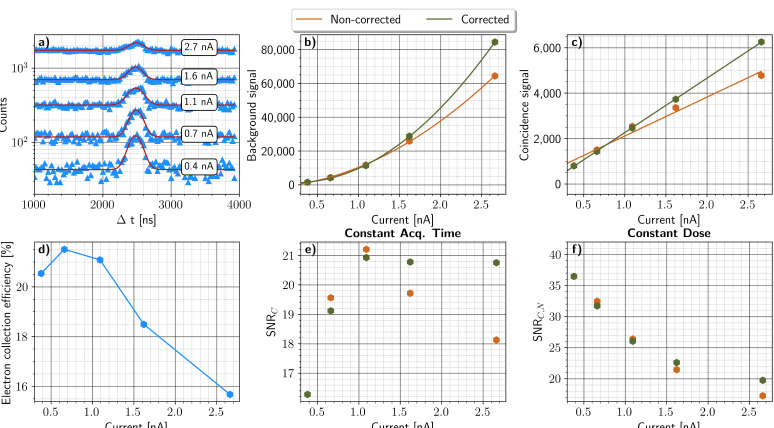
Figure 2. ( a ) Coincidence histograms as a function of time delay between EELS and EDX event streams for a varying beam current at constant acquisition time (y scale logarithmic). ( b ) The uncorrelated background signal as a function of incoming beam current (brown). The background scales quadratically with incoming current. In green, the corrected expected background signal which would be recorded for an ideal electron detector with constant efficiency as a function of current. ( c ) The number of coincidence events as a function of incoming current scales only linearly with incoming current. The corrected signal taking the efficiency into account is shown (green). Please note that the corrected fit better approximates a linear function. ( d ) The measured electron efficiency with a notable decrease for higher currents due to dead time in the detector. ( e ) The SNR of the coincidence signal as a function of incoming current when using a constant acquisition time. ( f ) The signal-to-noise (SNR) of the coincidence signal as a function of incoming current when the total dose has been